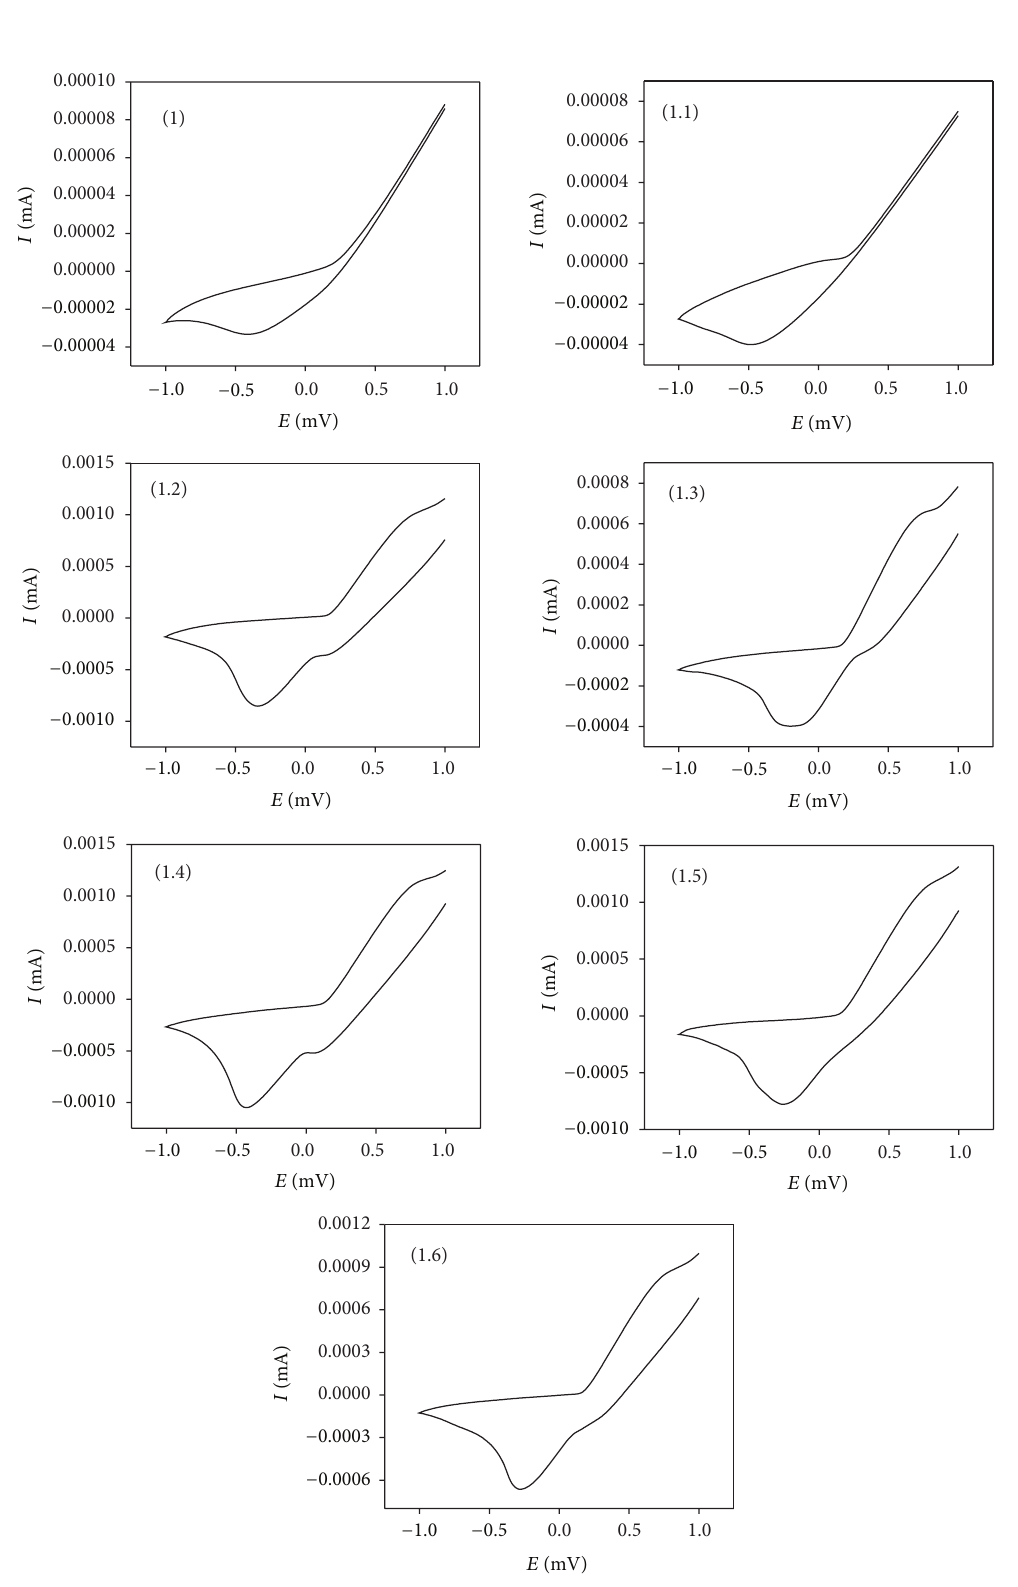
Figure 2: Cyclic voltammogram of ligand and its metal